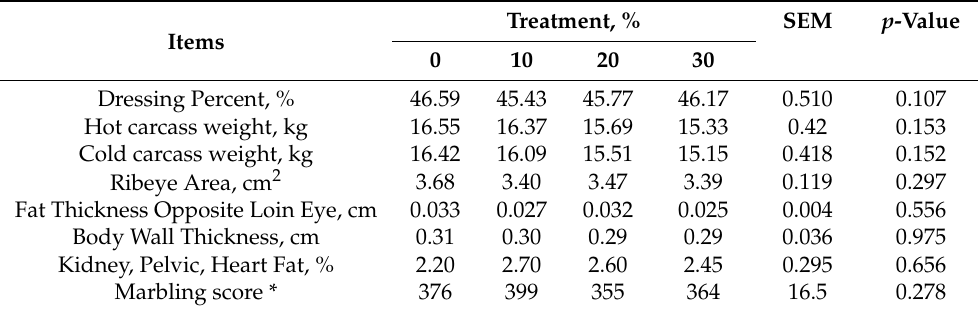
Table 3. Effects of varying levels of HSM supplementation on the carcass yields and quality measure- ments of meat goats.